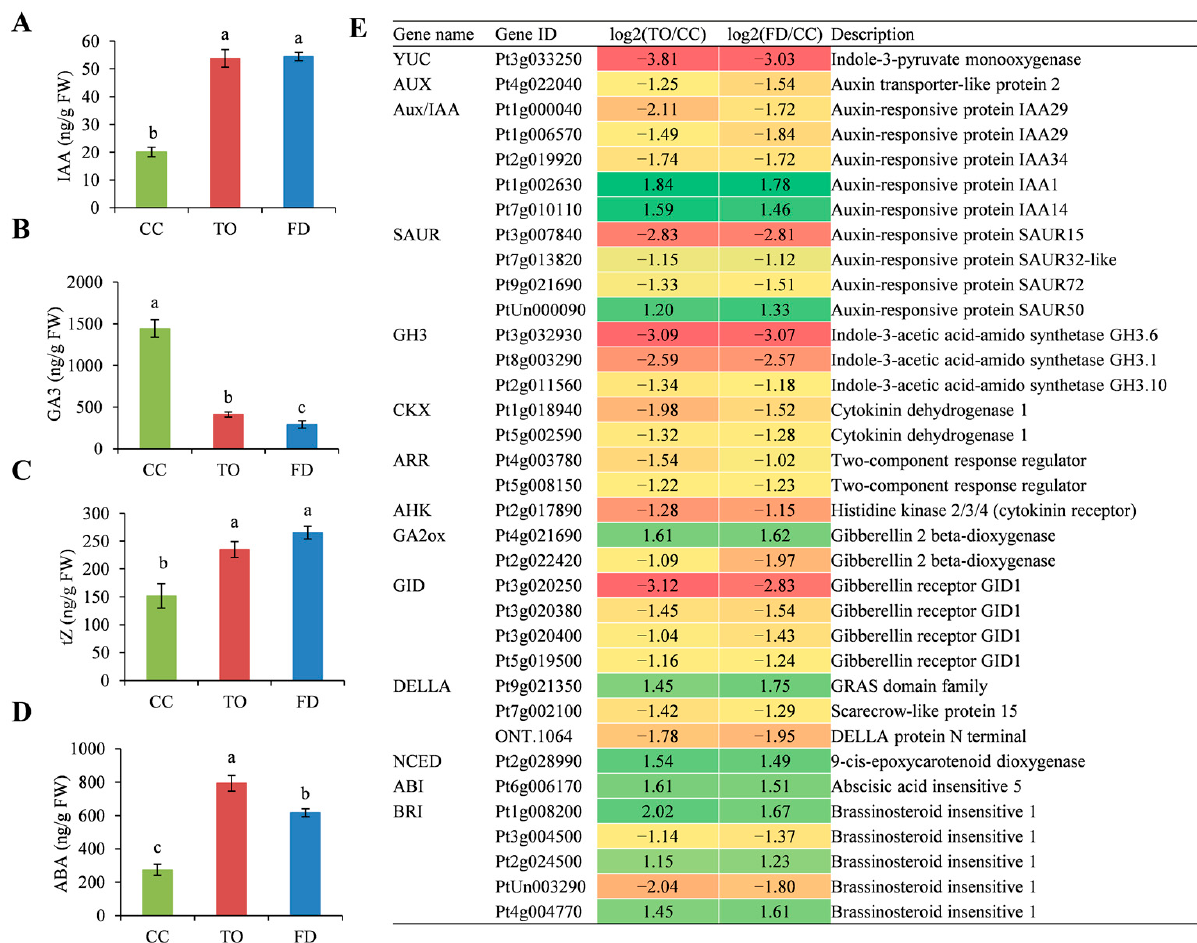
Figure 4. Changes in the content of IAA ( A ), tZ ( B ), GA3 ( C ), and ABA ( D ), and their metabolism-related gene expression ( E ). Different small letters indicate significant differences at p < 0.05 according to Duncan’s multiple range tests.